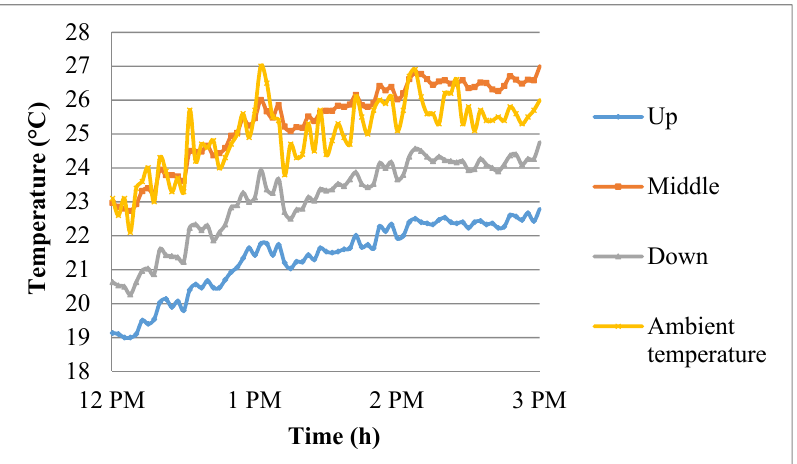
Figure 9. Time-temperature dependencies measured in different distances from the roof of the model cowshed with installation of monocrystalline PV module and the ambient temperature.